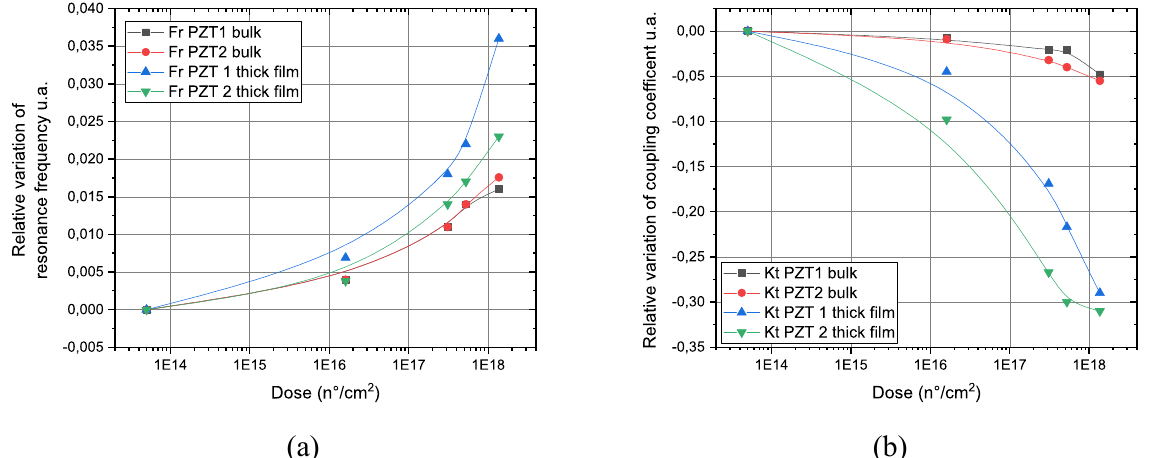
Figure 10 : comparison between PZ27 bulk and thick film. (a) relative variation of resonance frequency, (b) relative variation of electromechanical